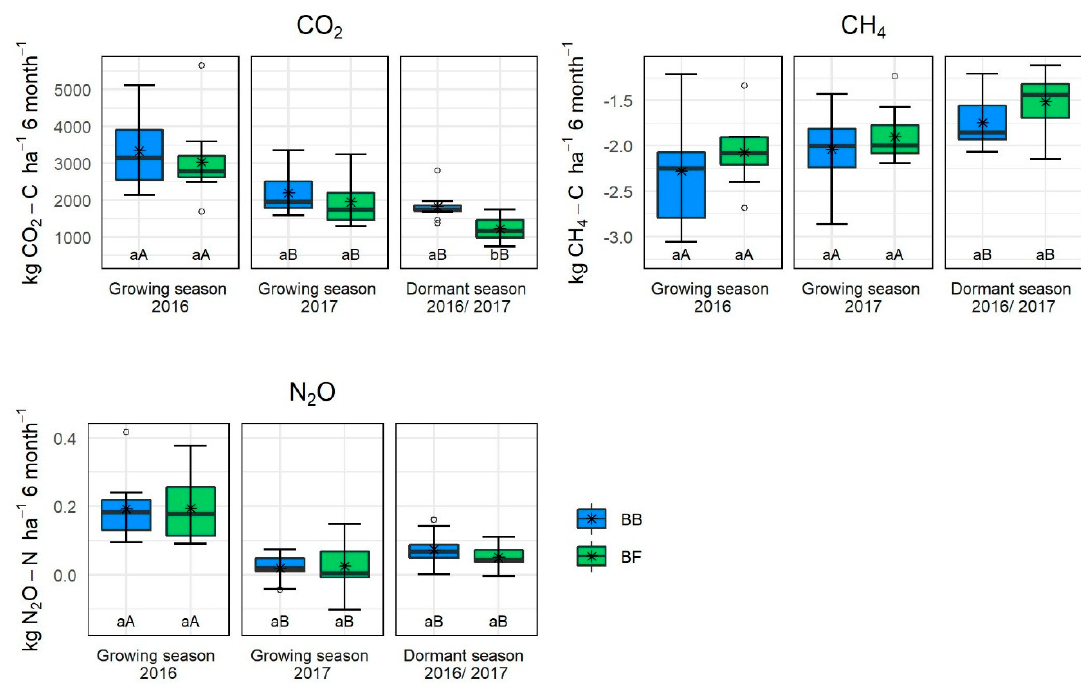
Figure 3. The cumulative fluxes of CO 2 , CH 4 and N 2 O for the growing seasons of 2016 and 2017 and the dormant season 2016/2017 for pure beech (BB, blue) and mixed beech-fir (BF, green) stands: The values are shown as boxplots with medians, the 25th and 75th percentile, the most extreme data points (whiskers´ extension), the outliners as unfilled circles as well as the means as asterisks ( n = 5–6). The small letters indicate significant differences between BB and BF; capital letters indicate significant differences between the seasons (normally distributed data: t-test/ANOVA and Tukey post hoc test; non-normal distributed data: Wilcoxon–Mann–Whitney test/Kruskal–Wallis and Bonferroni post hoc test, p < 0.05).